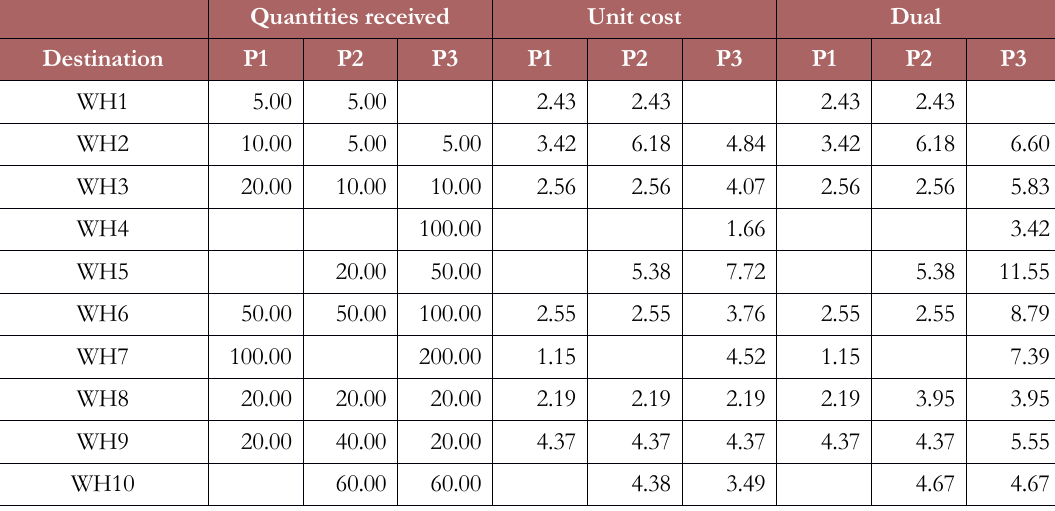
Table 6. Solution of a multiperiod